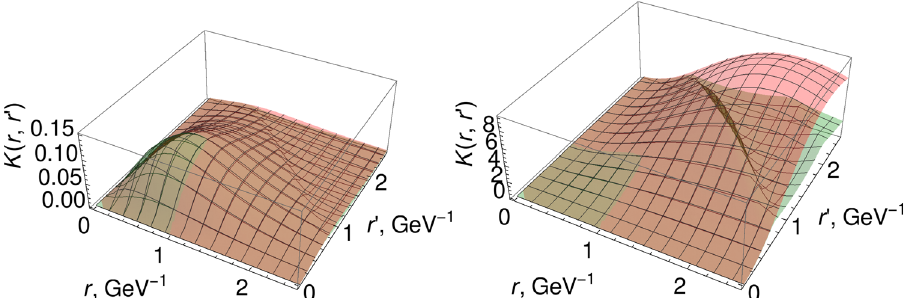
(cid:2) (cid:6)(cid:5) (cid:6) (cid:3) (cid:5) · Ψ ( r ) Ψ · Ψ ( r (cid:5) ) ∼ Ψ Fig. 10 Left: Function K r , r (cid:5) both plots the semitransparent pink surface corresponds to evaluation (cid:10) (cid:2) (cid:3) g M g M with CGC parametrization, and the semitransparent green surface cor- d φ Δ N r , r (cid:5) which appears in the integrand of (32,33) for x = respondstoevaluationwithparametrization(16).Thelatterhasavisible 10 − 3 and n = 8. Right: The same integrand for the hypothetic case cusp due to the discontinuity of the dipole amplitude of light meson production, with wave function (B.6) with parame- ter (meson size) R ∼ 1fm and light quark mass m q ≈ 0 . 3GeV. In